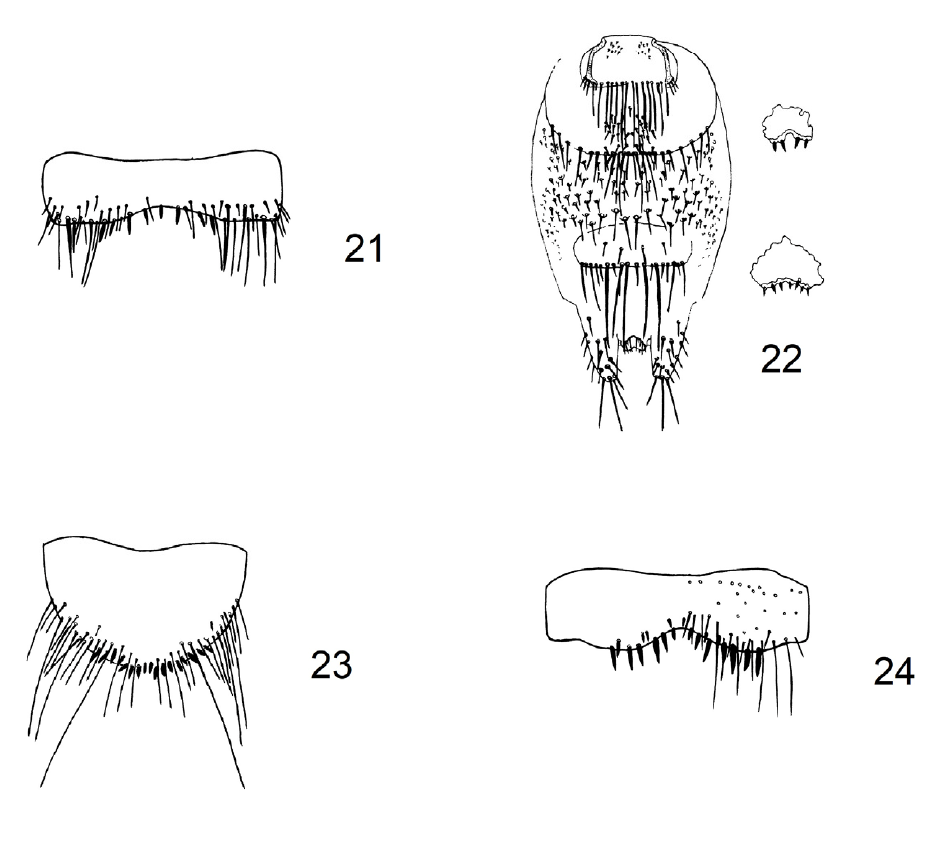
Figure 3. ( 21 ) Nycteribia ( Acrocholidia ) vexata Westwood, 1835, male, sternite 5; ( 22 ) Nycteribia ( Acro- cholidia ) vexata Westwood, 1835, female, abdomen, genital plate; ( 23 ) Nycteribia ( Nycteribia ) schmidlii Schiner, 1853, male, sternite 5; ( 24 ) Nycteribia ( Nycteribia ) latreillii (Leach, 1817), male, sternite 5; ( 25 ) Nycteribia ( Nycteribia ) pedicularia Latreille, 1805, male, sternite 5; ( 26 ) Nycteribia ( Nycteribia ) kole- natii Theodor and Moscona, 1954, male, sternite